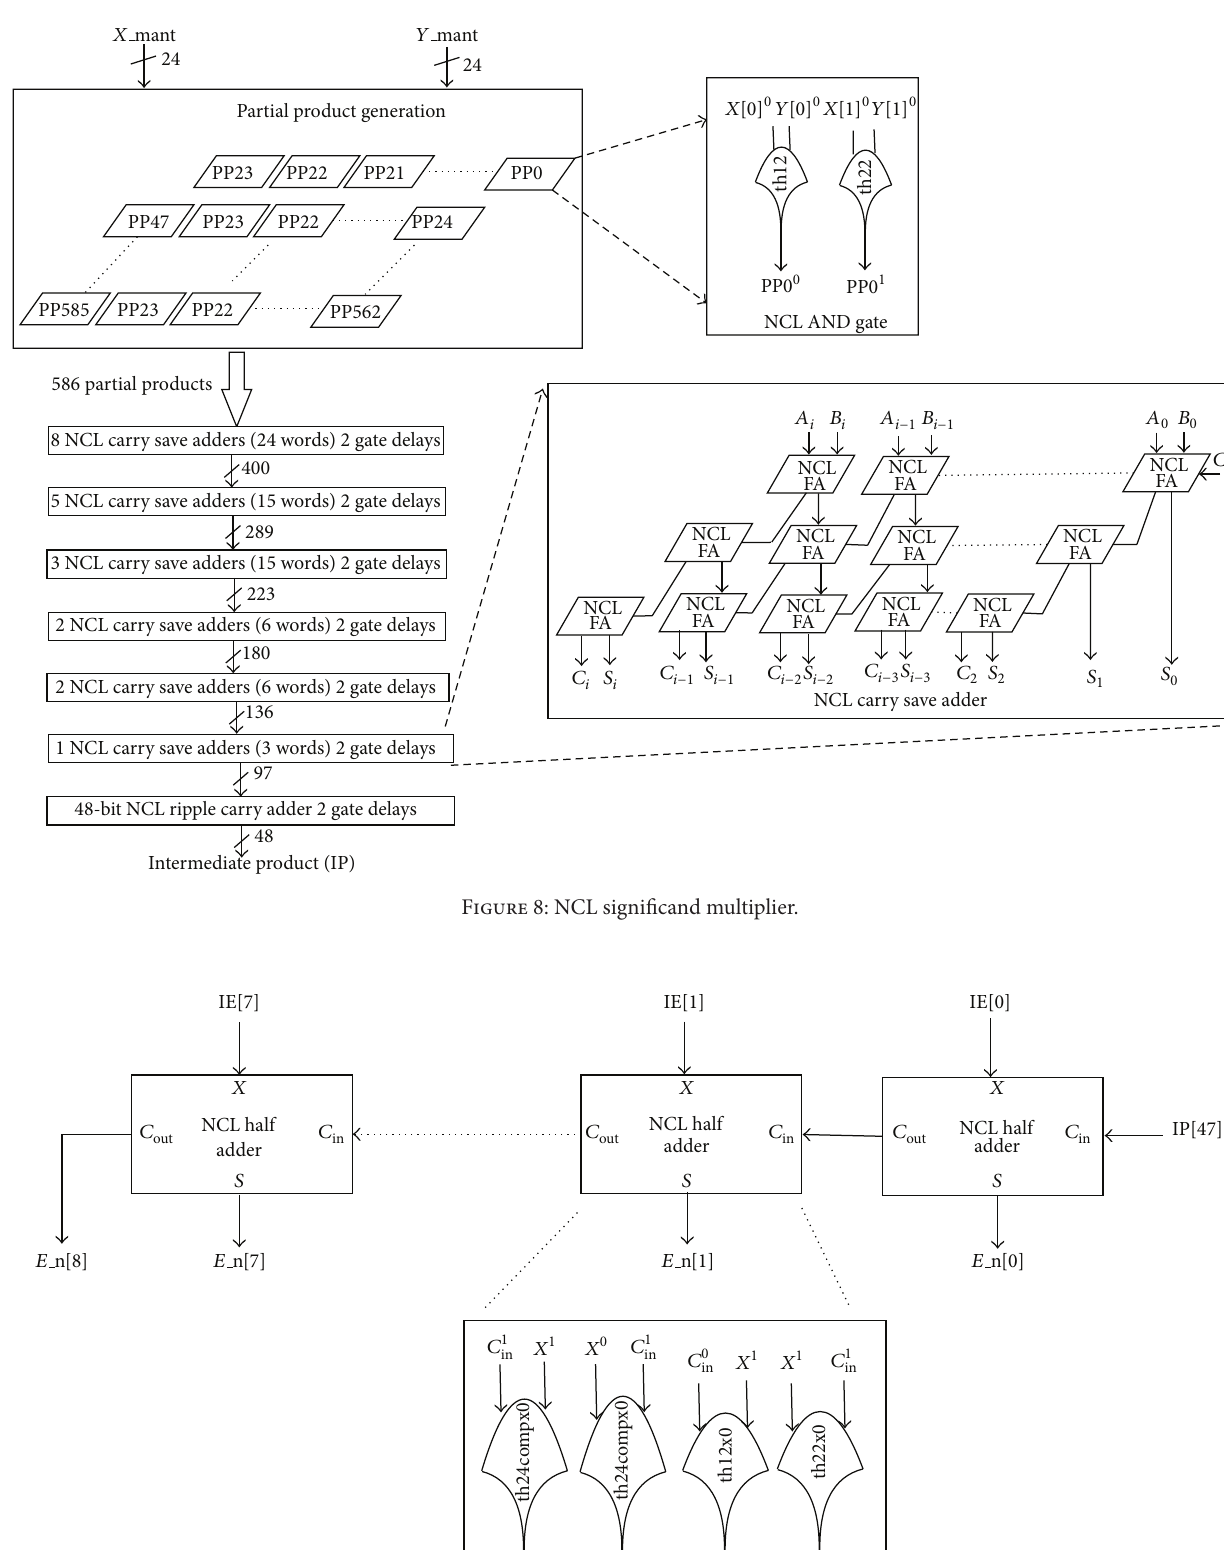
Figure 9: NCL exponent